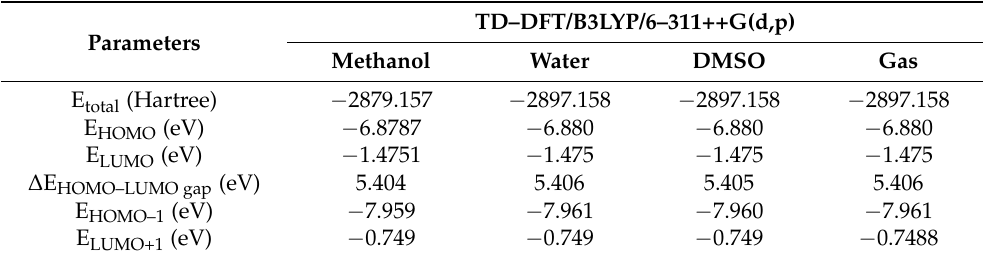
Table 3. Calculated energy values for the monomer of 3-Br-2-HyP in gas, water, DMSO and methanol solvents.